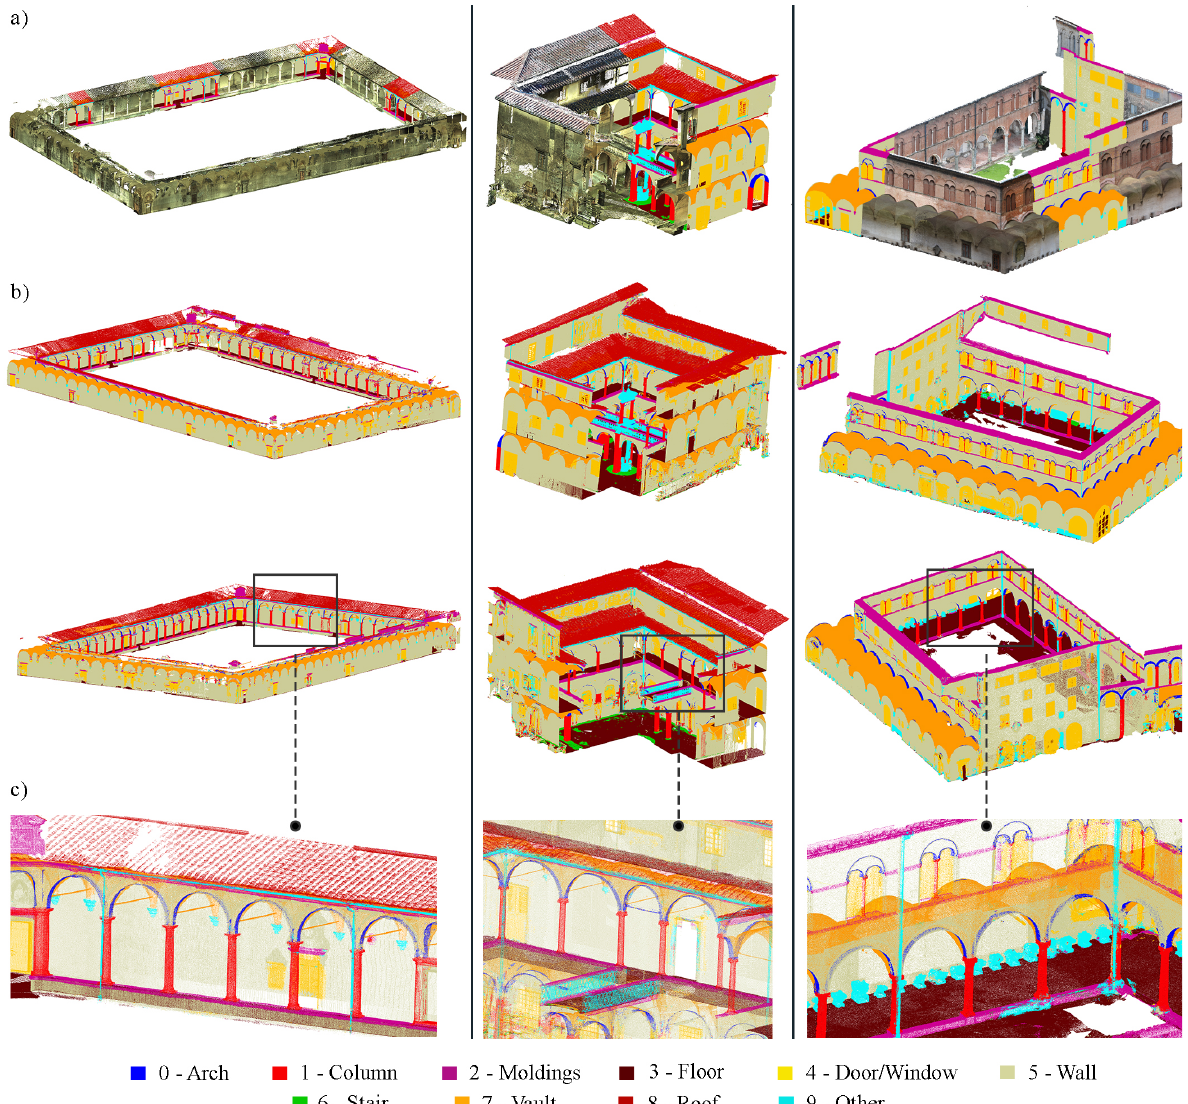
Figure 6. Training set (a) and segmentation results (b, c) for the three case